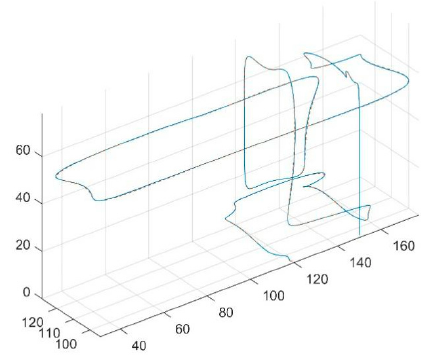
Figure 9. Comparison of desired trajectory and actual trajectory.